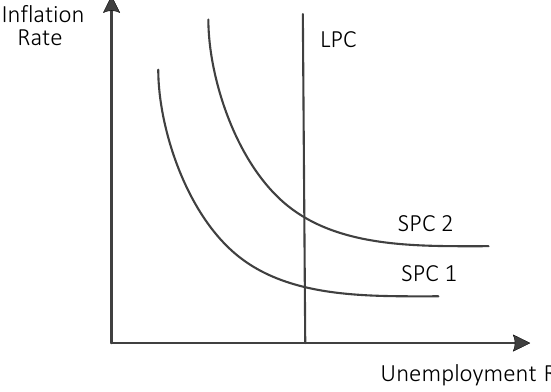
Unemployment Figure 1. Short-term and long-term Phillips curves